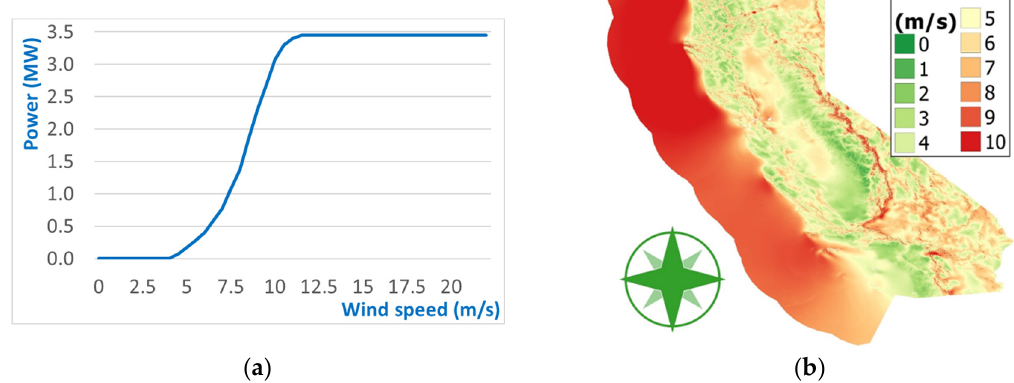
Figure 3. ( a ) Power table Vestas V136-3.45. ( b ) California wind speeds Global Wind Atlas.